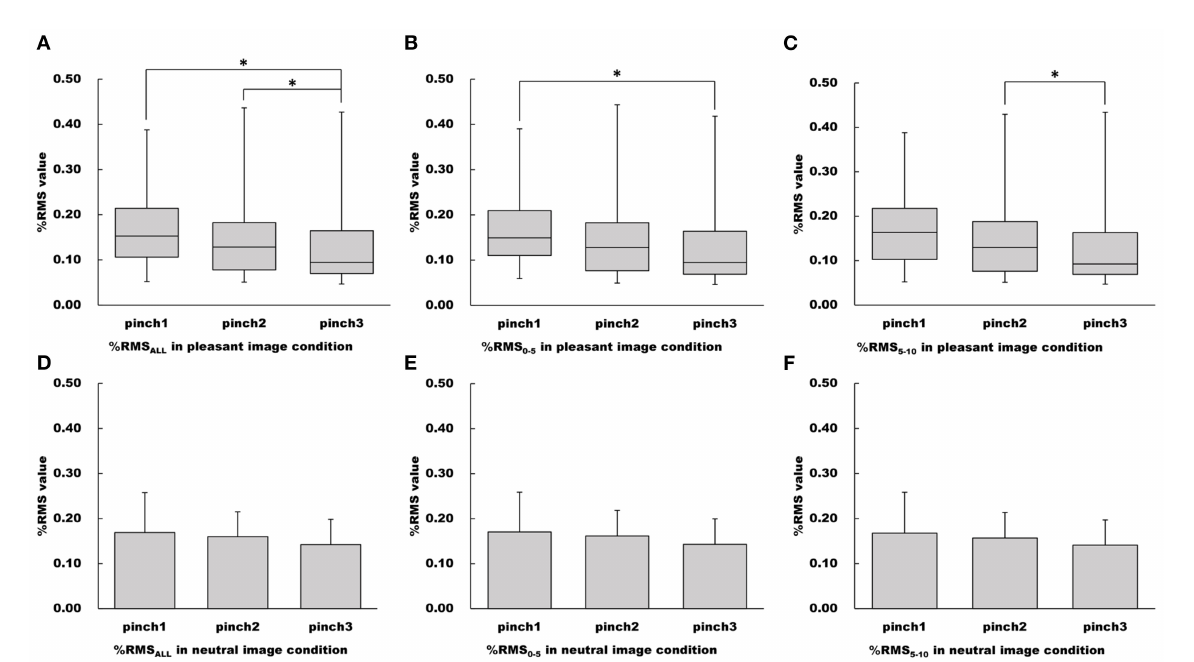
FIGURE7 Changes of %RMS values in the pleasant and neutral image conditions. (A–C) Show %RMS ALL , %RMS 0 − 5 , %RMS 5 − 10 values in the pleasant image condition, respectfully. (D–F) Show %RMS ALL , %RMS 0 − 5 , %RMS 5 − 10 values in the neutral image condition, respectfully. For parametric data, %RMS values are represented as mean and standard deviation. For non-parametric data, %RMS values are represented using the box and whisker plot, with the median shown as the middle horizontal line, the upper and lower quartiles indicated as boxes, and the maximum and minimum indicated as whiskers. The vertical axis shows %RMS, and horizontal axis shows the specific trial (Pinch 1, 2, and 3). * p < 0.05.